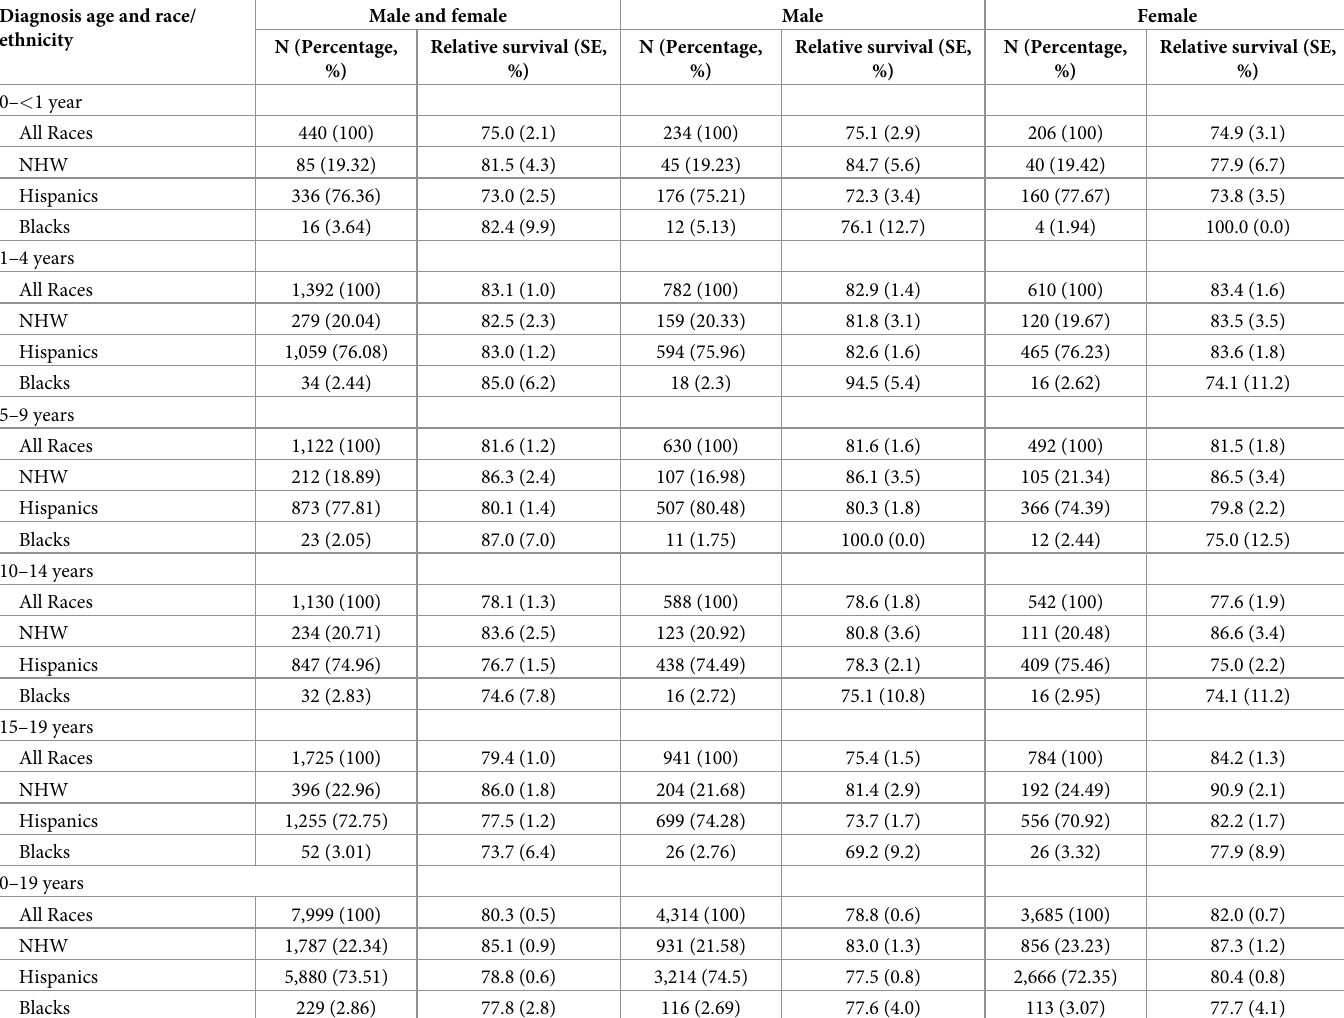
Table 1. South Texas childhood cancer 5-year relative survival in different gender and races/ethnicities, 1995–2017 a